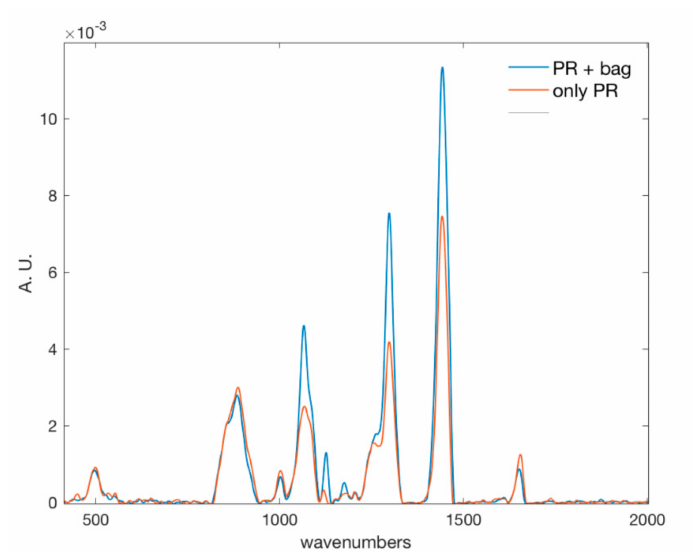
Figure 8. For the same sample the spectrum acquired on grated PR as such (red line) and on packaged grated PR (blue line) are shown. Where the plastic absorbs, the intensity of the blue line is higher than the intensity of the red